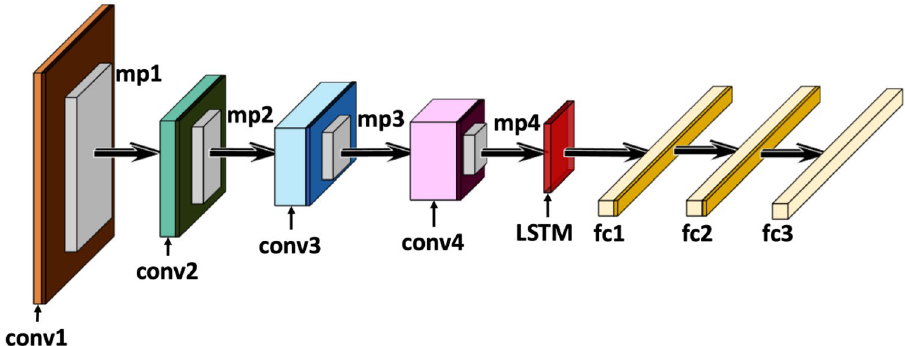
Figure 2. Proposed Model Architecture. Dark coloured boxes indicate a ReLU activation function at the end of a convolution "conv" layer. The max-pooling operation is represented by the nomenclature "mp" and the fully connected dense layers are denoted by